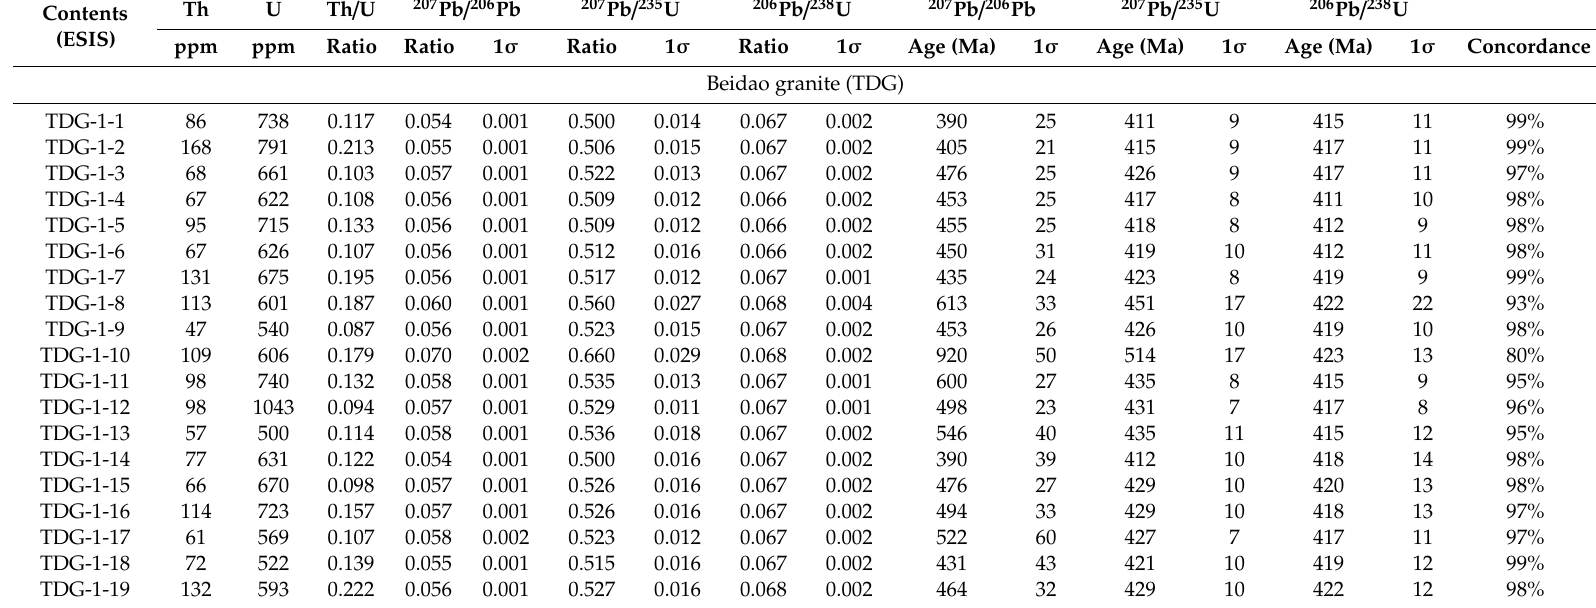
Table 3. Zircon LA-ICP-MS U-Pb results for the Tianshui area